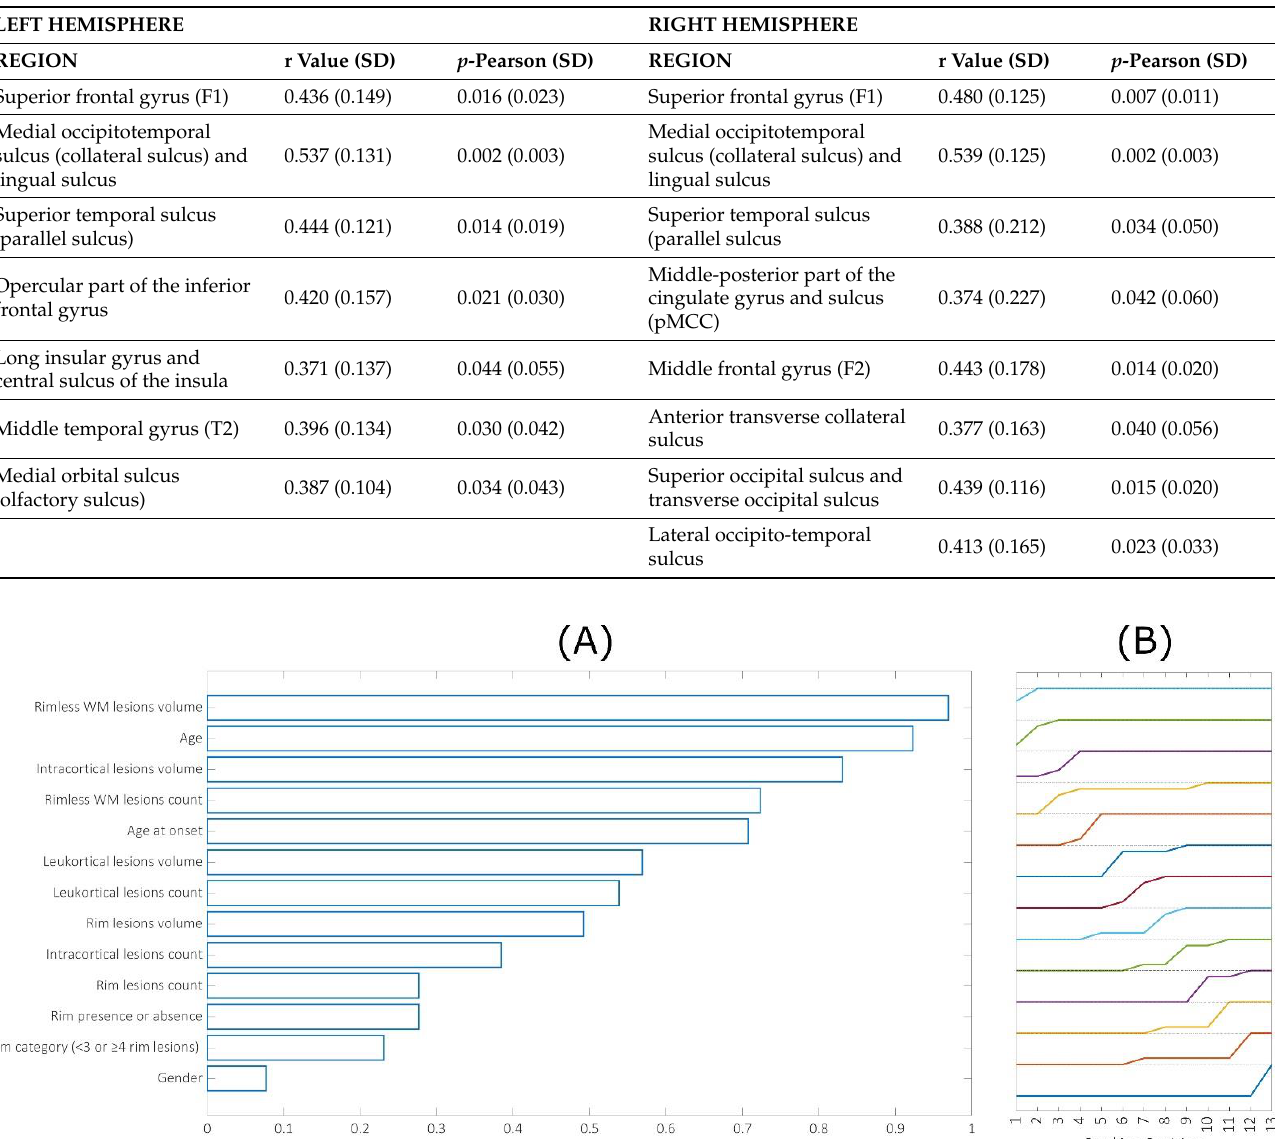
Table 2. Prediction performances of local cortical thickness values in 15 brain regions belonging to both brain hemispheres where p value < 0.05.